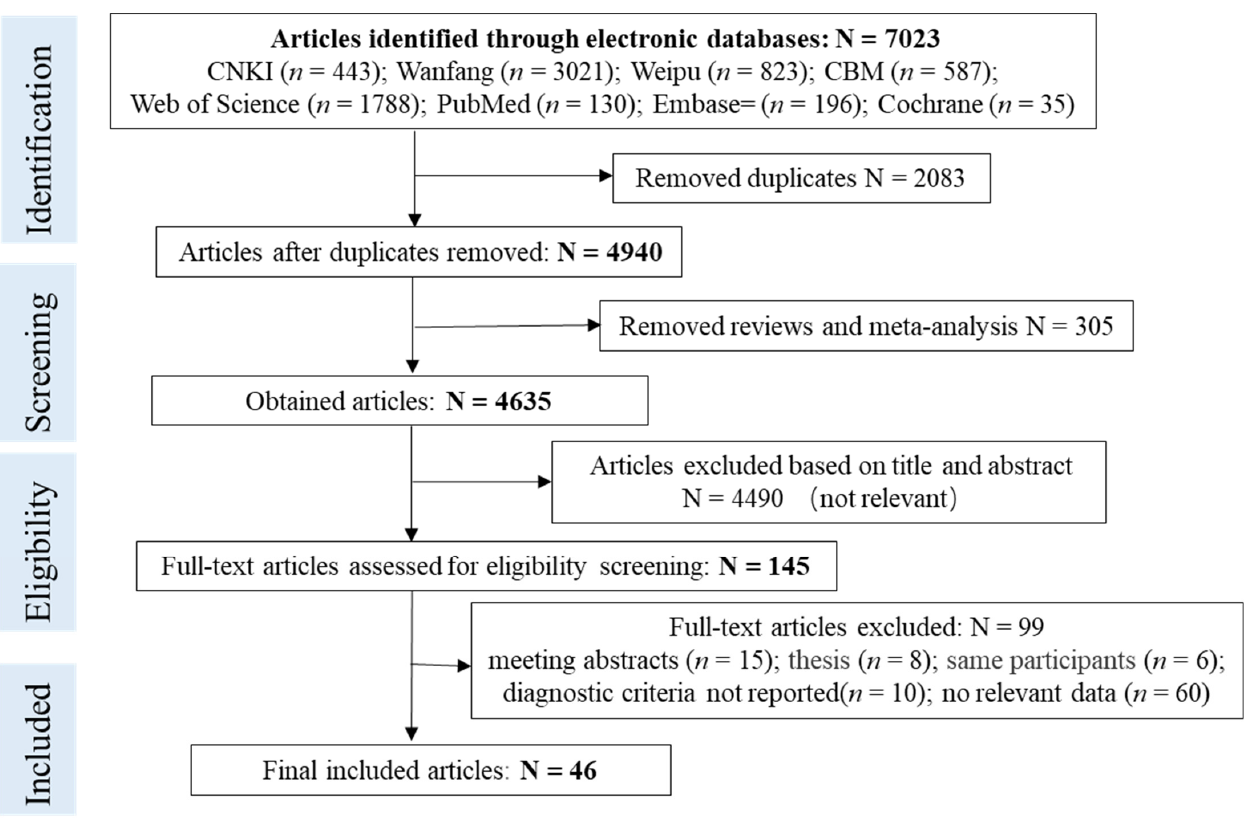
Figure 1. PRISMA flowchart for screening articles. Table 1. Characteristics of included